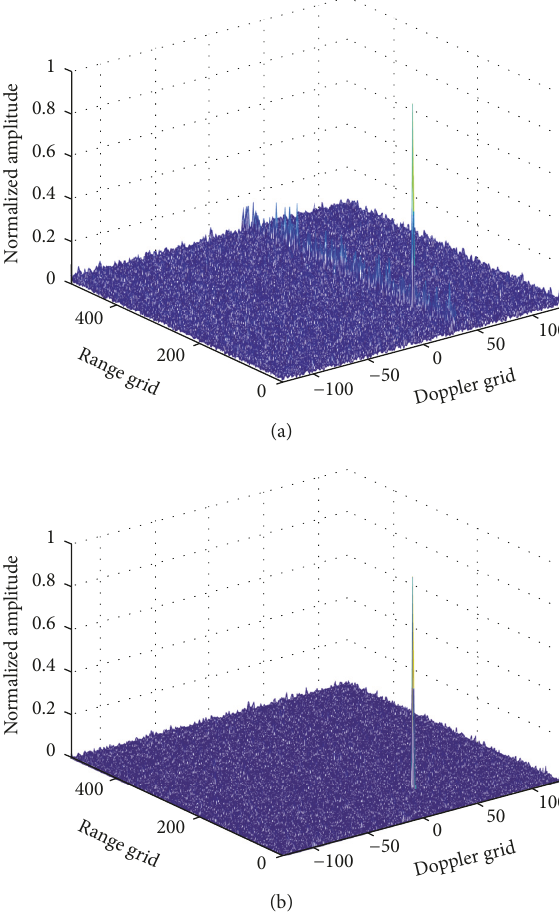
Figure 6: Range and Doppler estimation of single target when SNR = − 20 dB. (a) Symbol-Domain and (b) Symbol-Domain